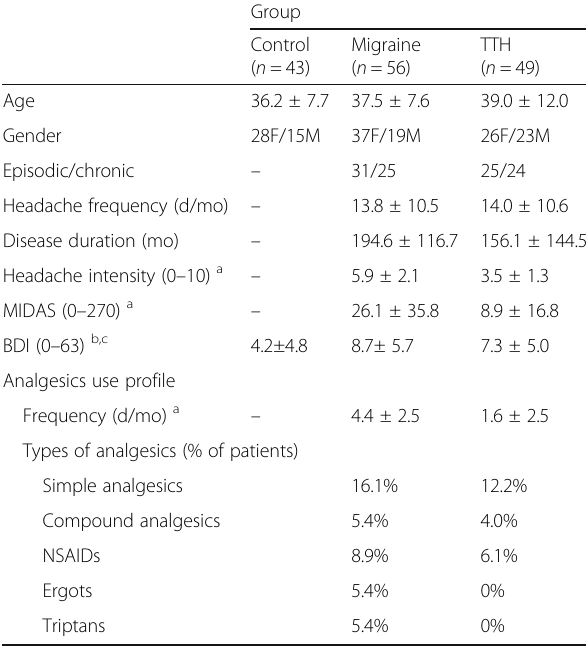
Table 1 Demographics and clinical profile of the three participant